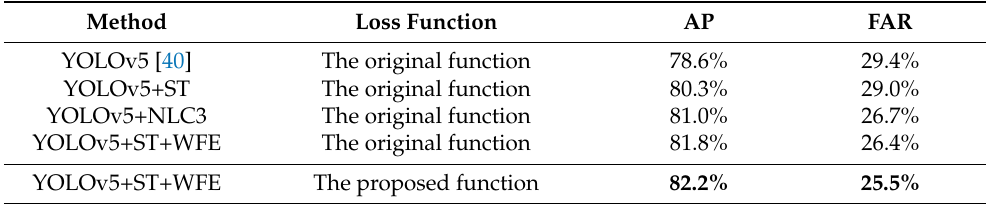
Table 1. Ablation experiments of our proposed method. The bold highlights the best performance.